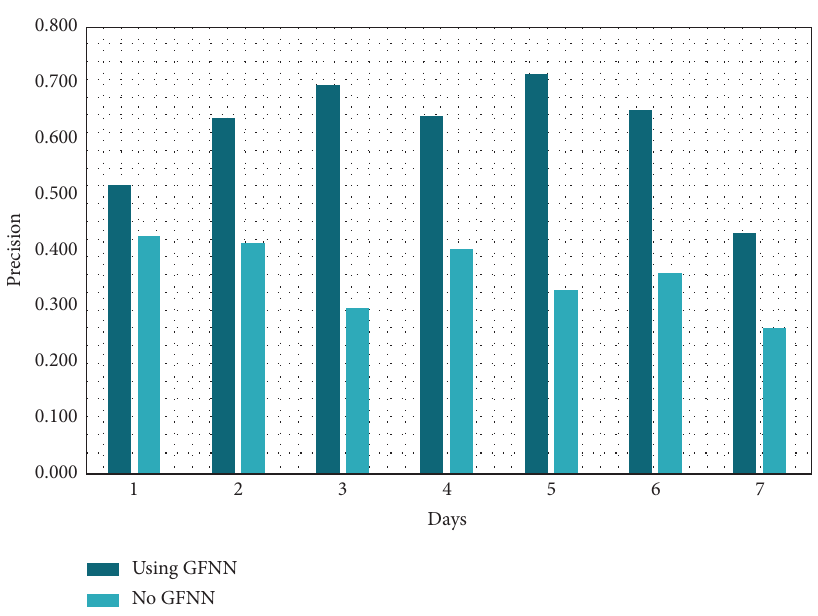
Figure 8: System accuracy test